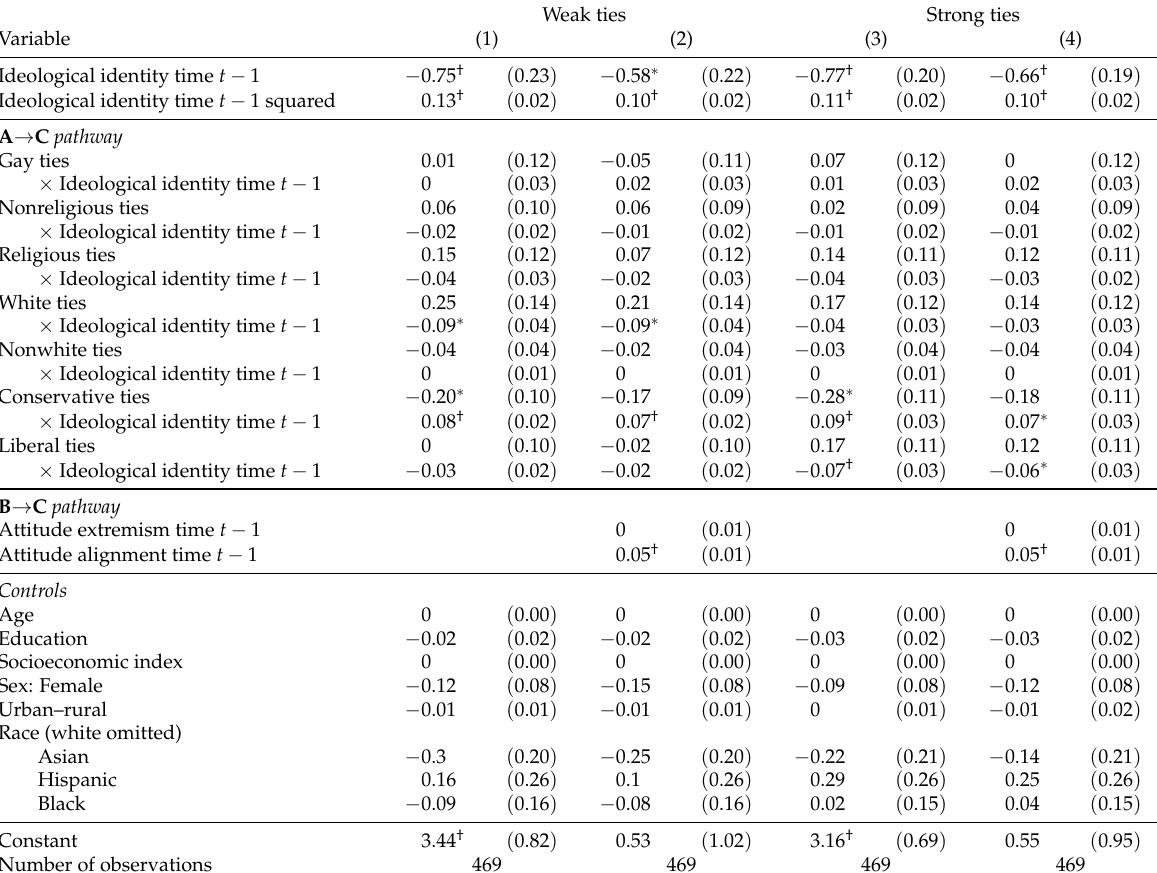
Table 1: HLMs predicting subsequent ideological identity